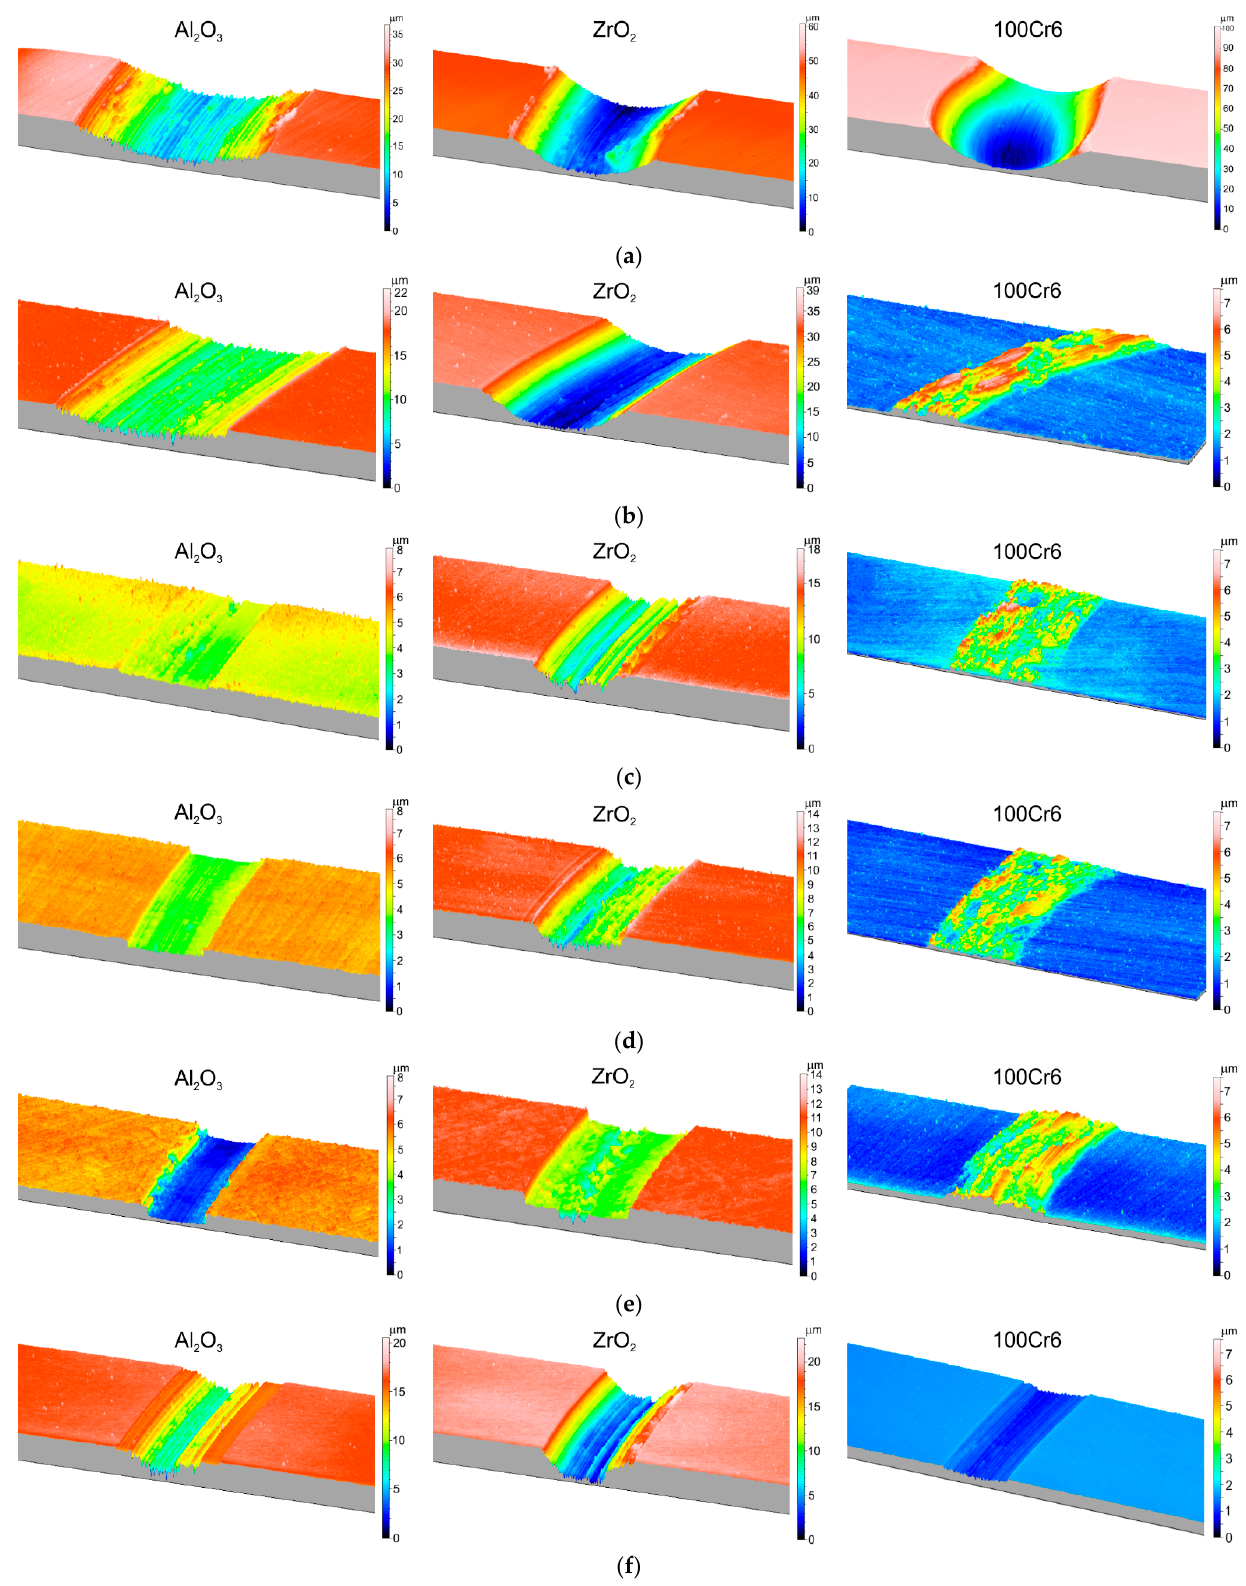
Figure 9. The 3D isometric images of the wear traces formed on the Ti-6Al-7Nb alloy surface after friction contact with Al 2 O 3 , ZrO 2, and 100Cr6 balls (( a )—non-oxidized condition, ( b )—600 ◦ C/72 h, ( c )—650 ◦ C/72 h, ( d )—700 ◦ C/72 h, ( e )—750 ◦ C/72 h, ( f )—800 ◦ C/72